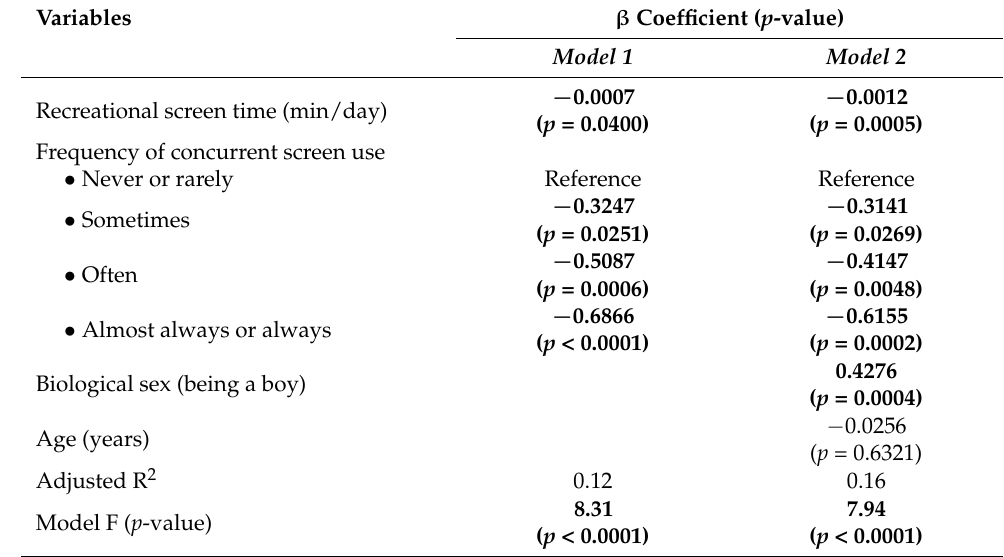
Table 3. Association between adolescents’ recreational screen time and sleep quality ( n =